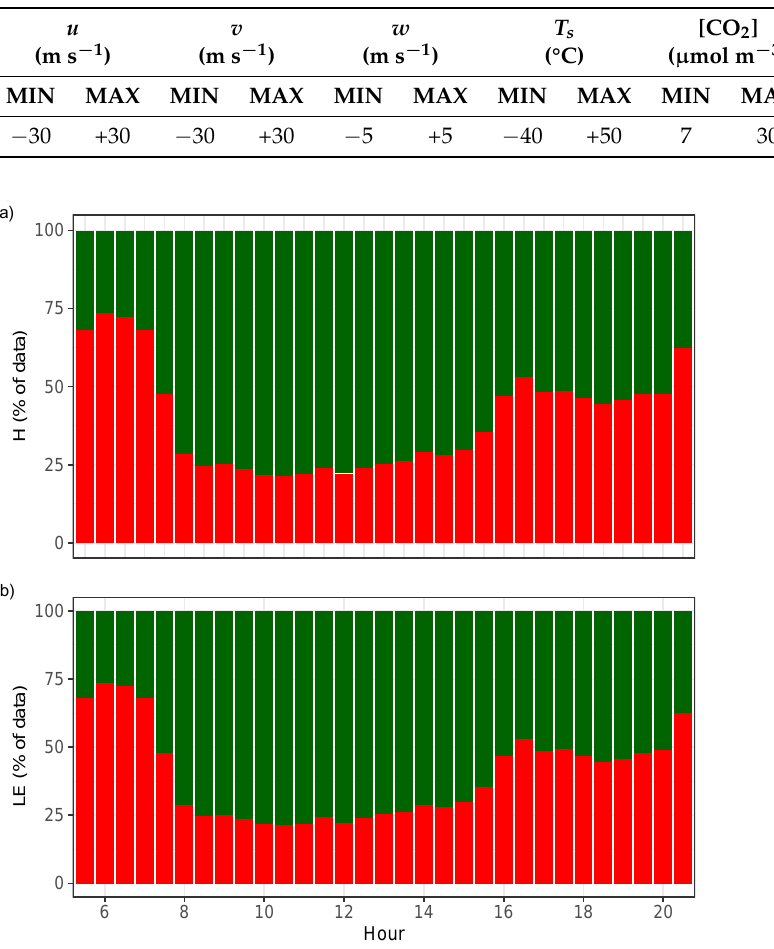
Figure A3. Mean diurnal cycles for quality control on the data set. Green: good quality data. Red: bad quality data. ( a ) Sensible heat flux. ( b ) Latent heat flux.